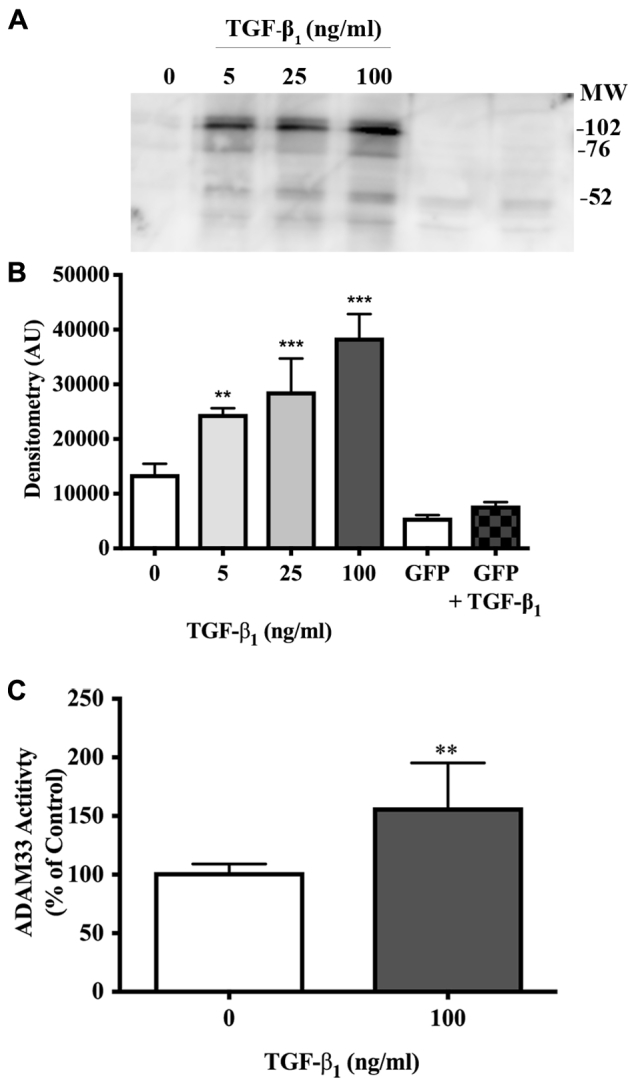
TGF-β enhances shedding of murine ADAM33. Cos-7 cells transiently transfected with full-length murine ADAM33 or green fluorescent protein (GFP) as control were treated with TGF-β as indicated. Soluble ADAM33 immunoreactivity and enzyme activity in cell-free supernatants were assessed by Western blotting (A) with densitometry (arbitrary units, AU) (B) or fluorescence resonance energy transfer peptide cleavage assay, respectively; enzyme activity is expressed as percent of activity found in supernatants from control untreated cells (C). Data are mean + SD and are representative of 4 independent experiments. MW, Molecular weight. **P < .01. ***P < .001.